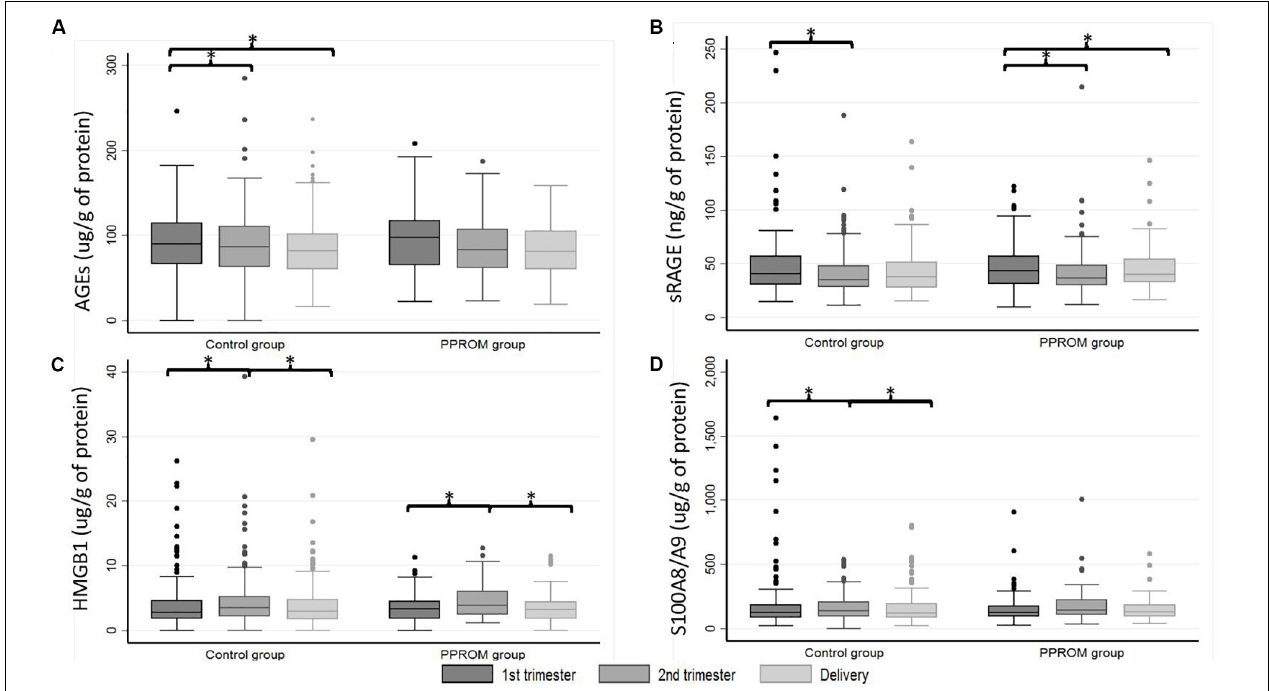
FIGURE 2 | Box plot of AGEs (A) , sRAGE (B) , HMGB1 (C) , and S100A8/A9 (D) serum-extracted extracellular vesicle median concentrations from 82 women in the PPROM group and 164 women in the control group at three points: first trimester, second trimester, and delivery. * p < 0.05 (random-effects for repeated measures). AGEs, advanced glycation end products; HMGB1, high-mobility group box 1; PPROM, preterm premature rupture of membranes; sRAGE, soluble receptor of advanced glycation end products.